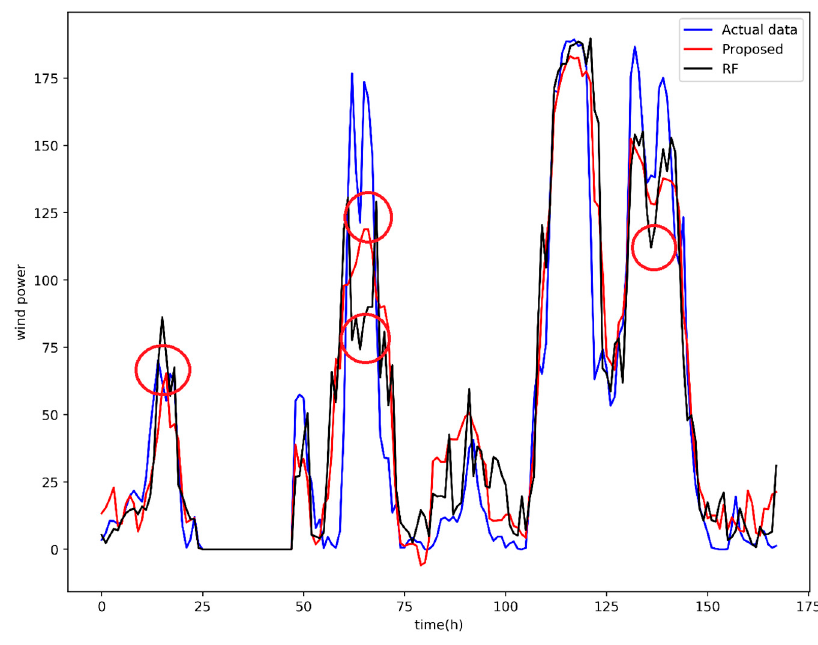
Figure 6. WPF results of RF and the proposed model.